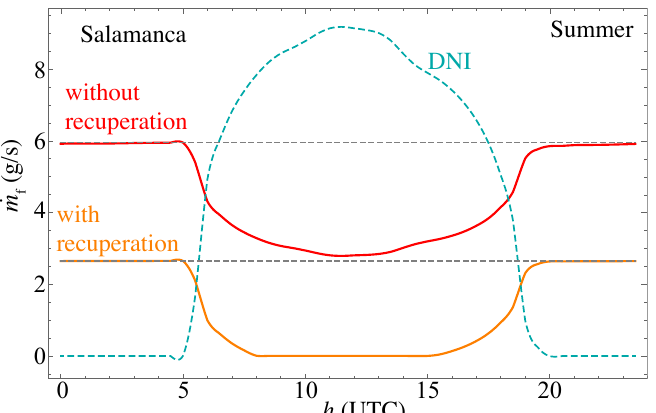
Figure 8. Instantaneous fuel consumption for plant configurations with or without recuperation. The particular case of Salamanca during a summer day for the power output level of P = 30 kWe is shown. The corresponding DNI is shown just as a